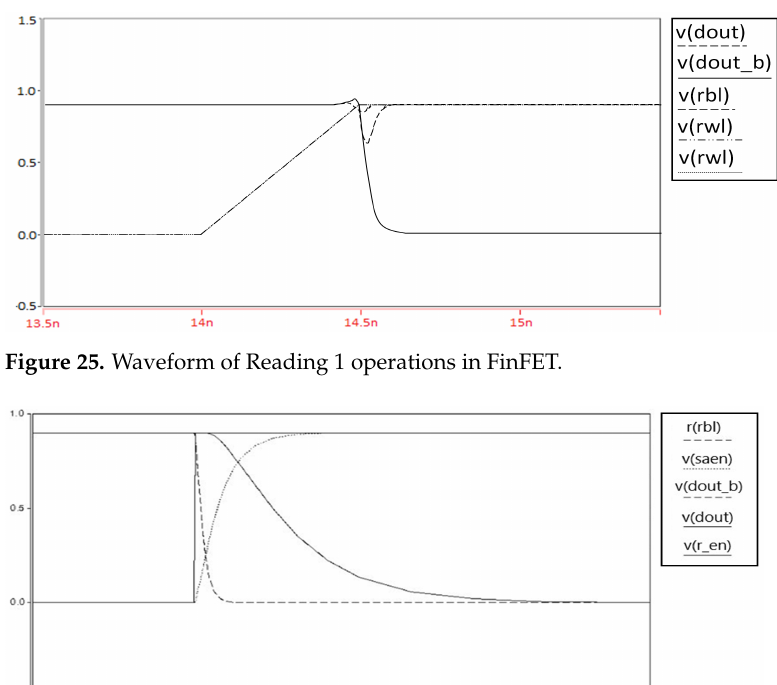
Figure 24. Waveform of Reading 0 operations in FinFET.